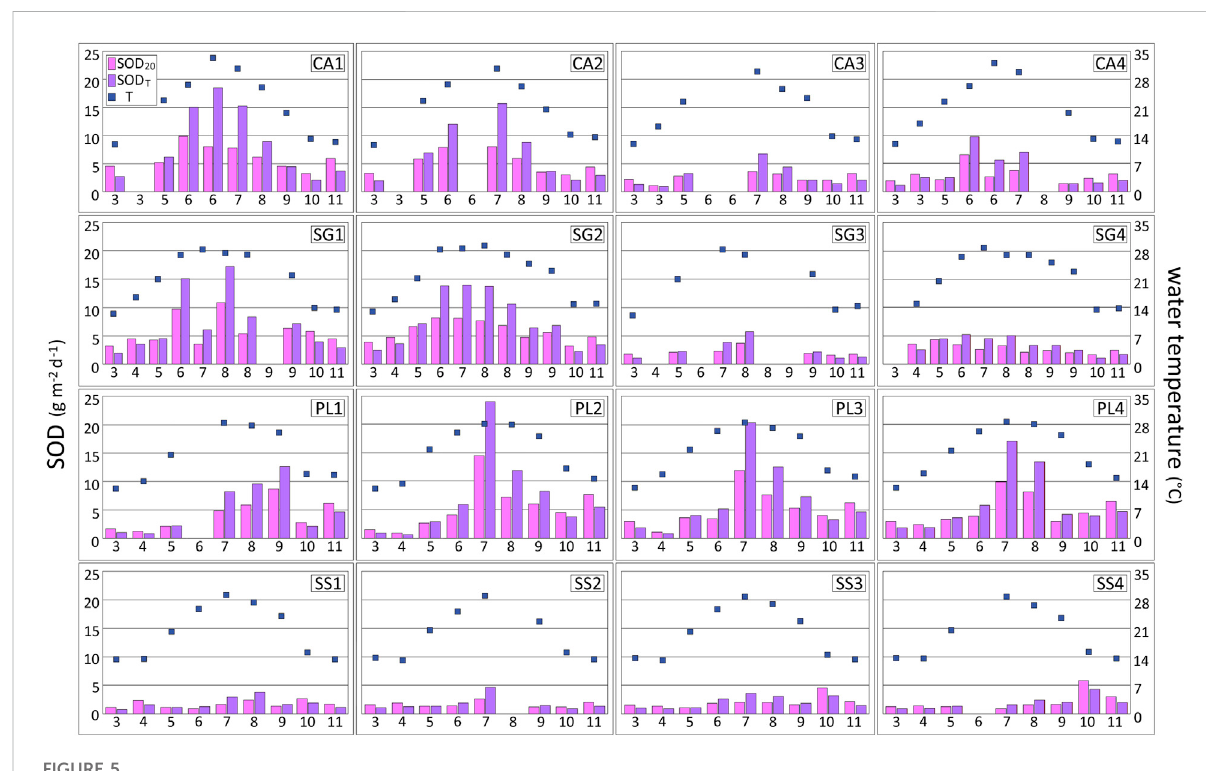
FIGURE 5 SOD T and SOD 20 2021 monthly trend rates at the 16 sites. Water temperature measured inside the benthic chamber is also shown. Two measurements were done in the CA area in June, and two in SG both in August and